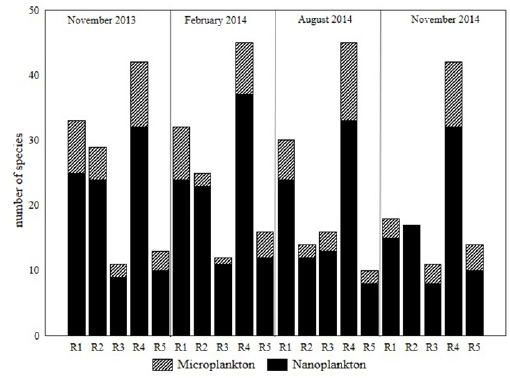
Figure 3. Temporal and spatial distribution of phytoplankton community size structure in reservoirs studied between November 2013 and November 2014